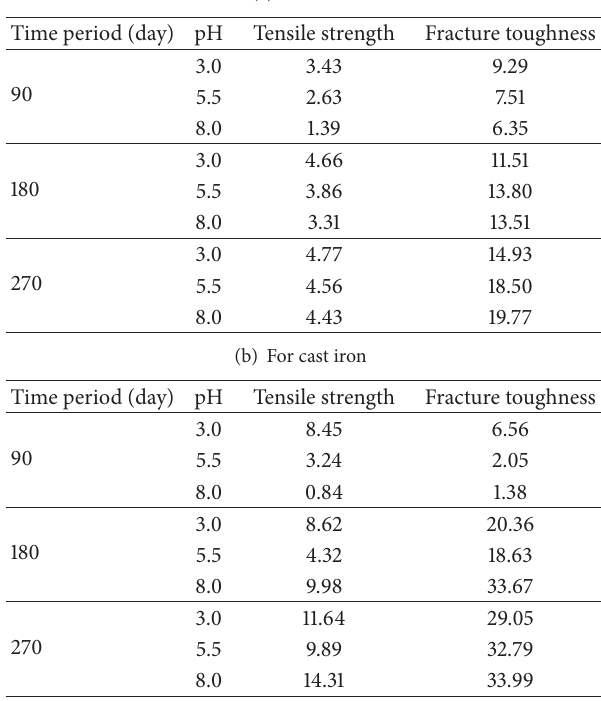
Table 4: Reduction of mechanical property